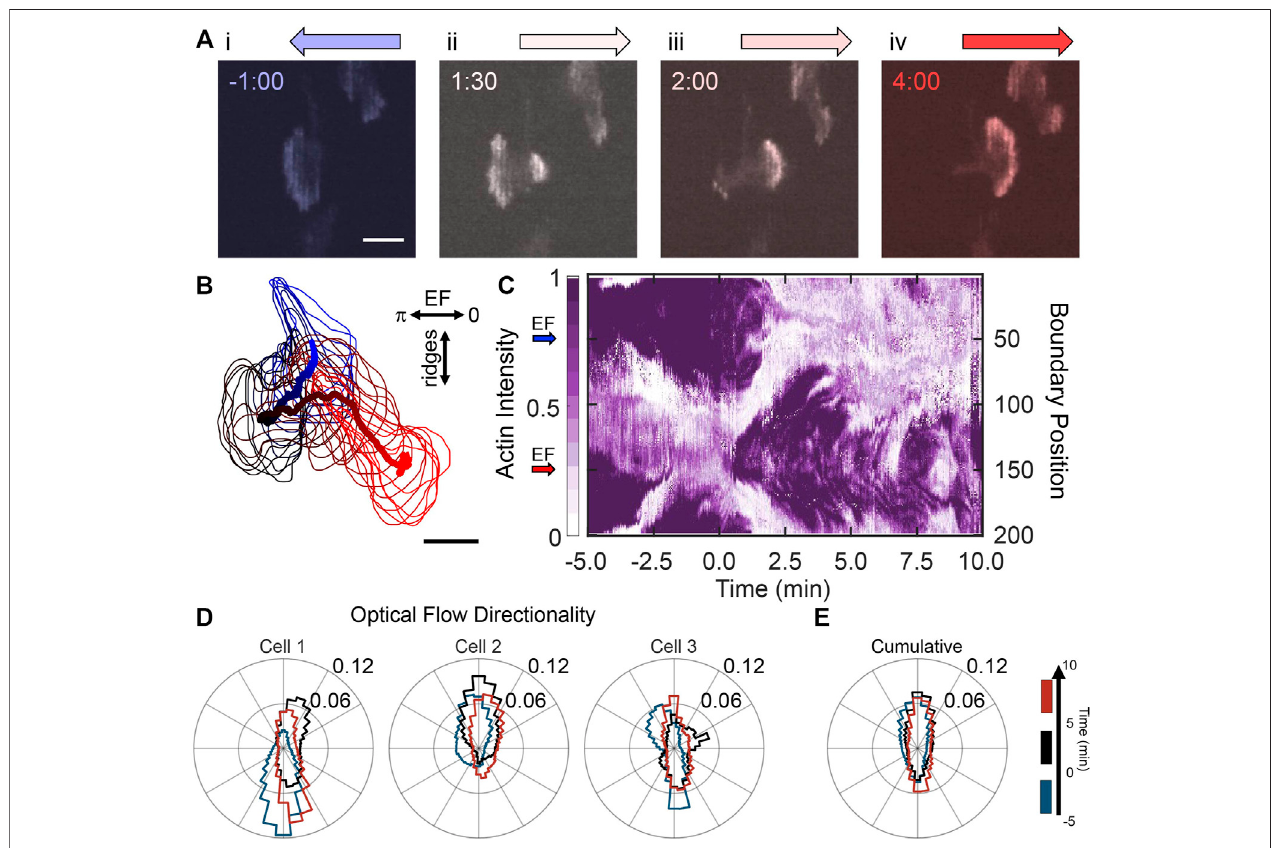
FIGURE3| NanoridgesdominatethelocalguidanceofactinwavesinthepresenceofcompetingEFguidance. (A) AYFP-actin-labelled,differentiatedHL60cellon nanoridges aligned perpendicularly to the EF. The cathodal direction is to the left at negative times; the EF reversal occurred at time zero. (B) Path of a cell centroid with boundary shape from − 5 to 10 min, plotted every 0.5 min. (C) Evolution of normalized boundary actin fl uorescence intensity. (D) Three characteristic examples of individualcellnormalizeddistributions(incounts)ofoptical- fl owdirectionsonperpendicularnanoridges,shownforthetimeranges:(blue)5 minbeforethe fi eldwas reversed; (black) 5 min after the fi eld was reversed; and (red) the period 5 – 10 min after the fi eld was reversed, leftmost distribution for cell in (A – C) . (E) The cumulative fl ow-direction distribution for the same time intervals for all cells (n = 9).